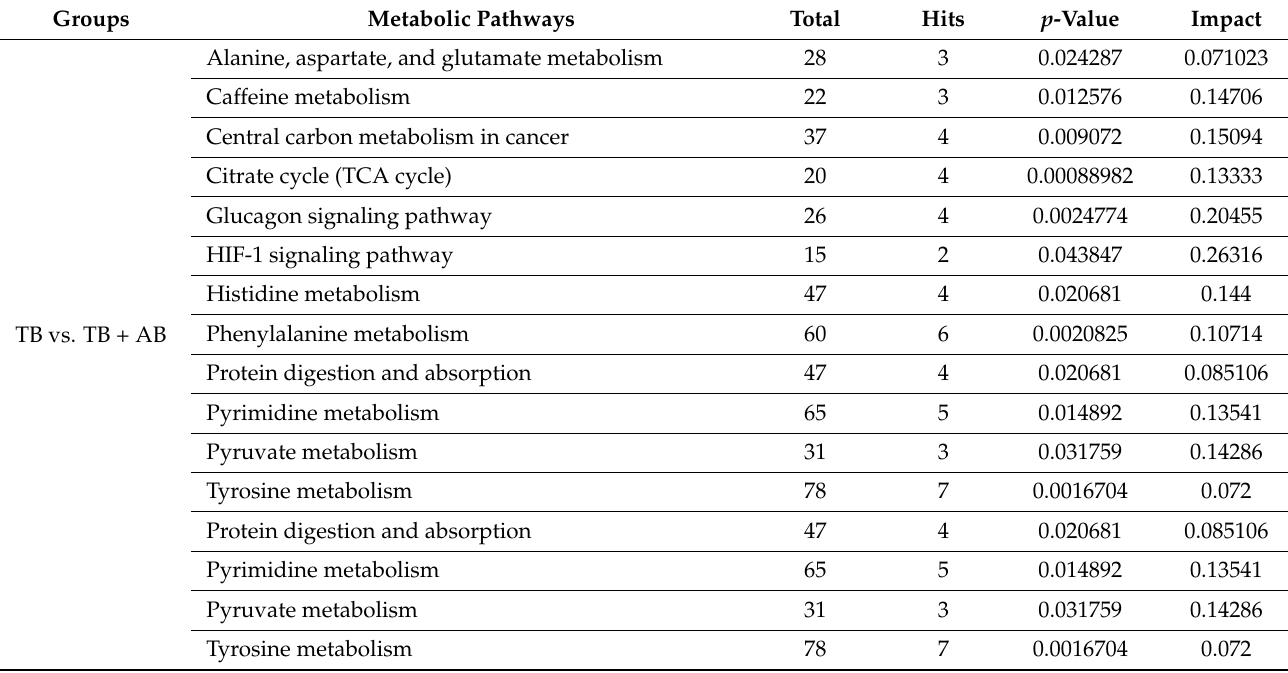
tein digestion and absorption pathway could be important contributors to TB to reduce body weight gain through gut microbiota.